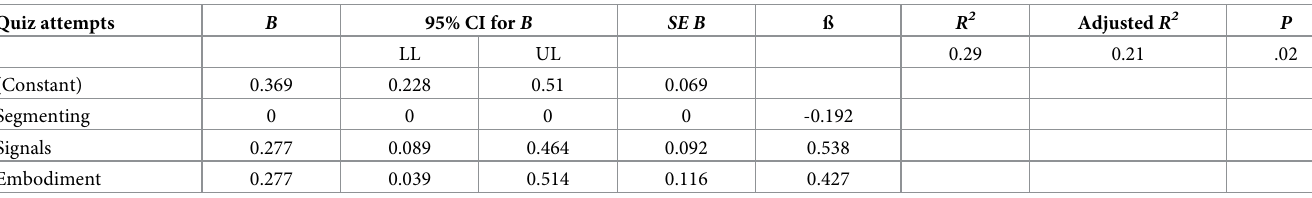
Table 5. Multiple regression results for the number of attempts made the quizzes that accompanied each multimedia lecture.